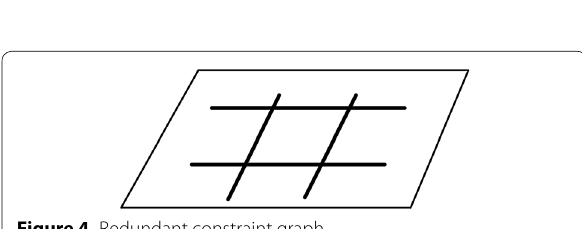
Figure 4 Redundant constraint graph